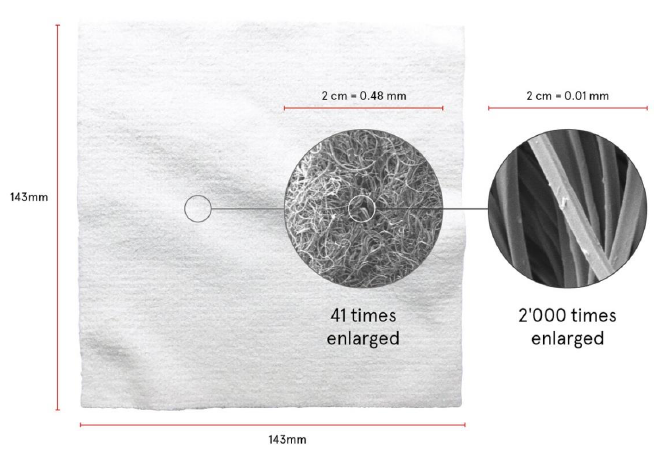
Figure 1. Microfiber wipe in total and magnifications of filaments.